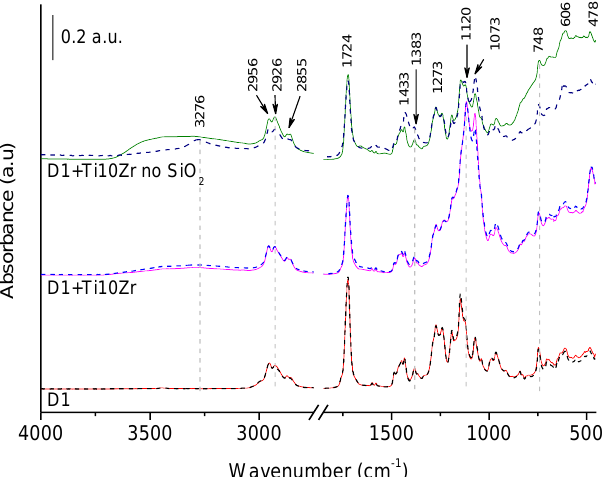
Figure 11. ATR-FTIR spectra of fresh (solid lines) and samples irradiated in Suntest for 14 days (dashed lines).